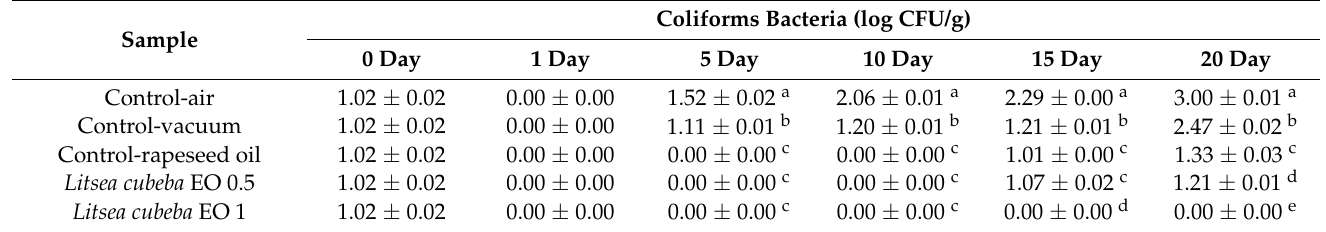
Table 2. Average numbers of coliforms bacteria (CB) log CFU/g in samples of deer meat during 20 days of storage at 4 ◦